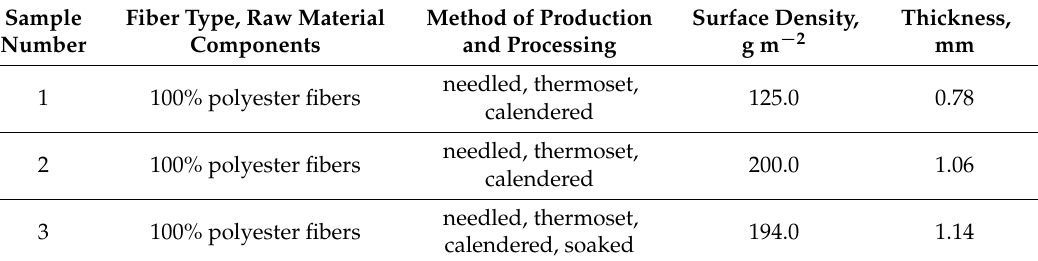
Table 1. Value of geotextile nonwoven materials